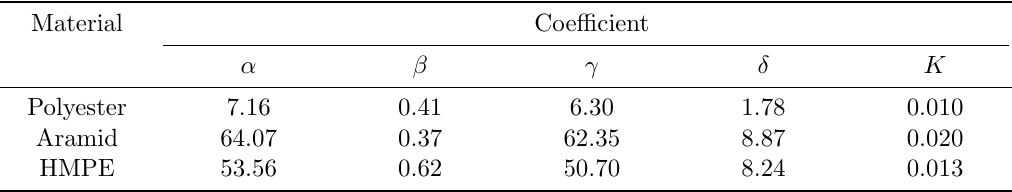
Table 2: Rope material coefficients for ropes tested in (Liu et al.,